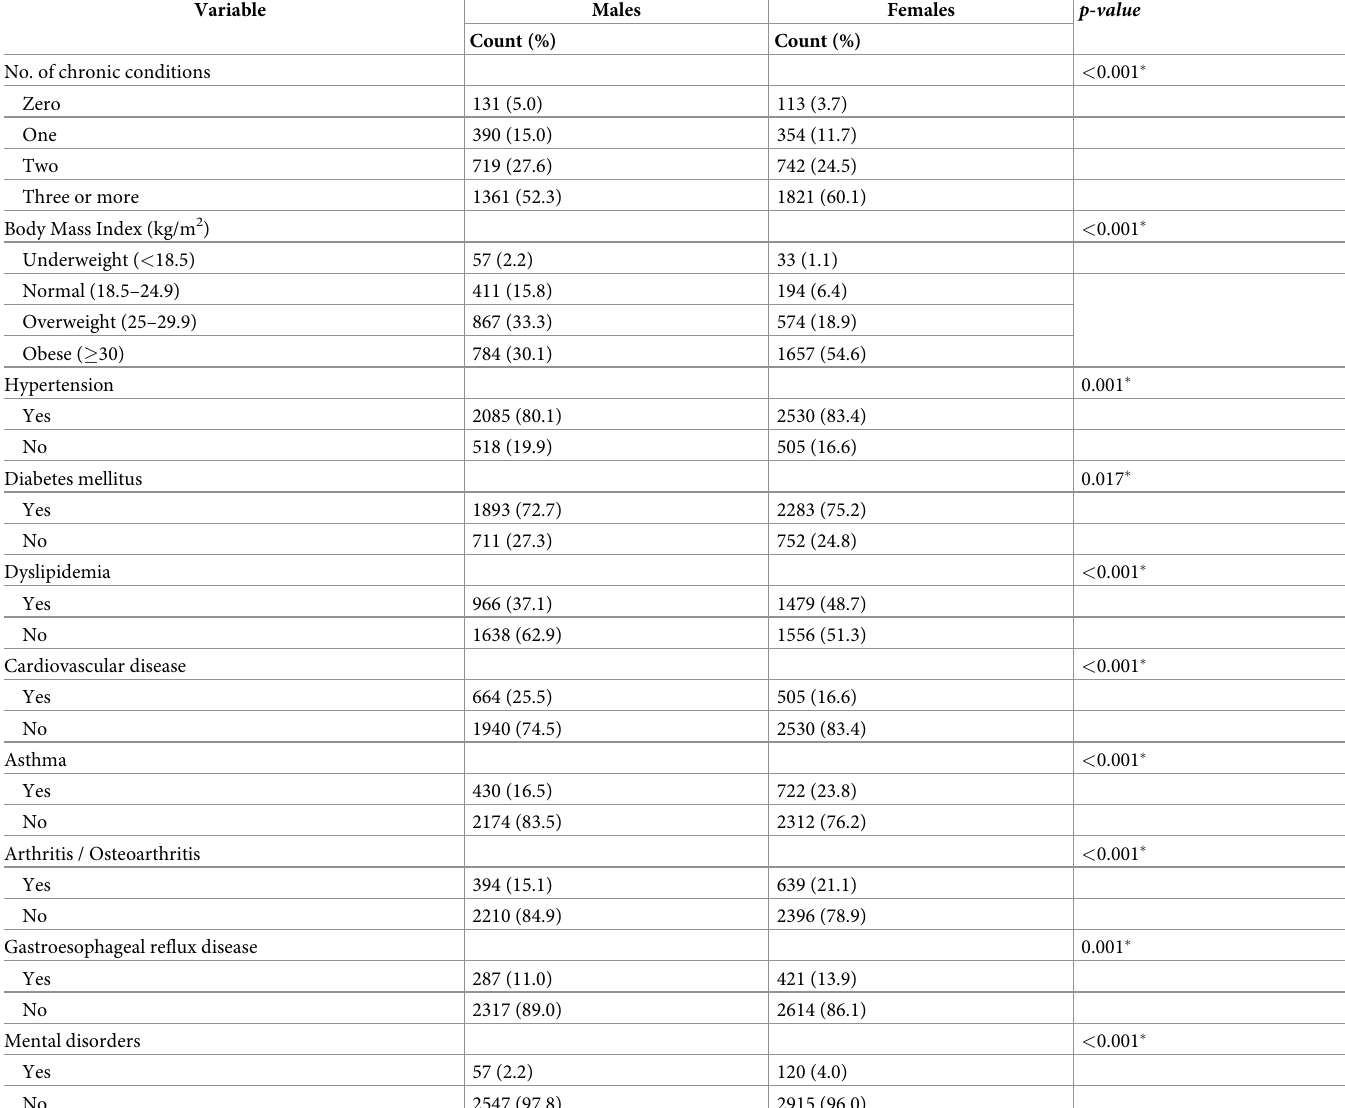
Table 2. Comparison of non-communicable diseases between males and females (N = 5639).